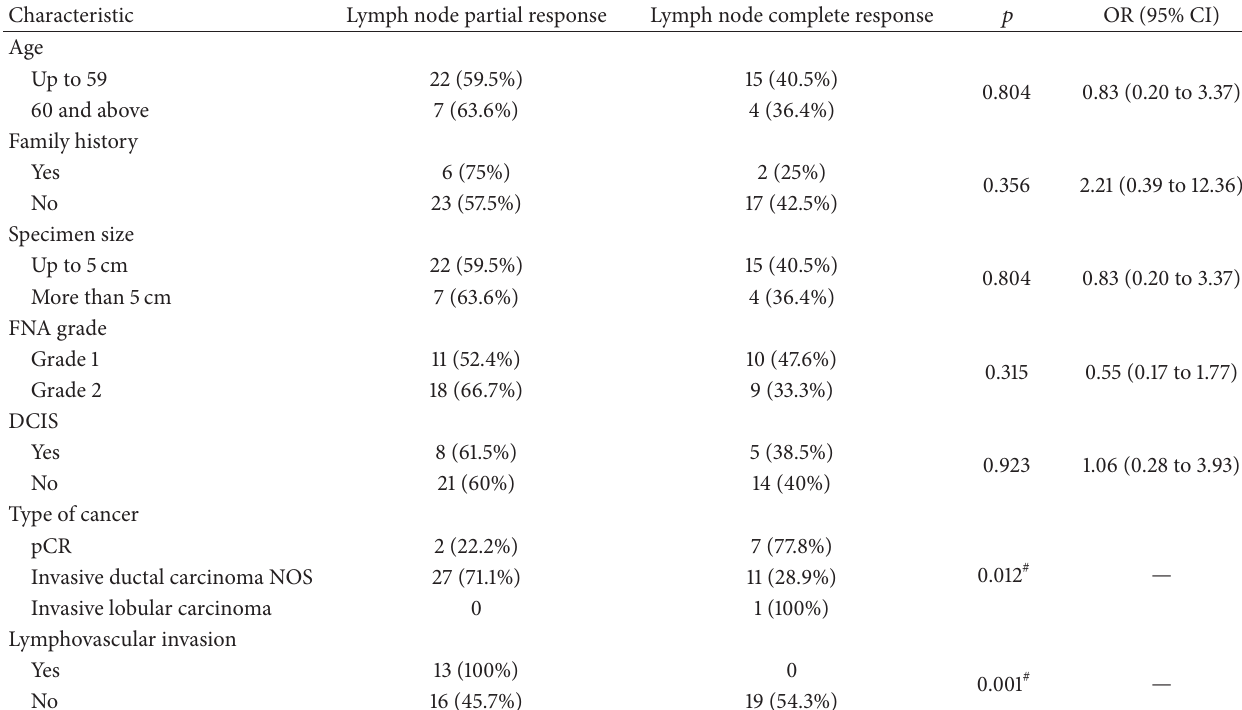
Table 7: Factors affecting lymph node